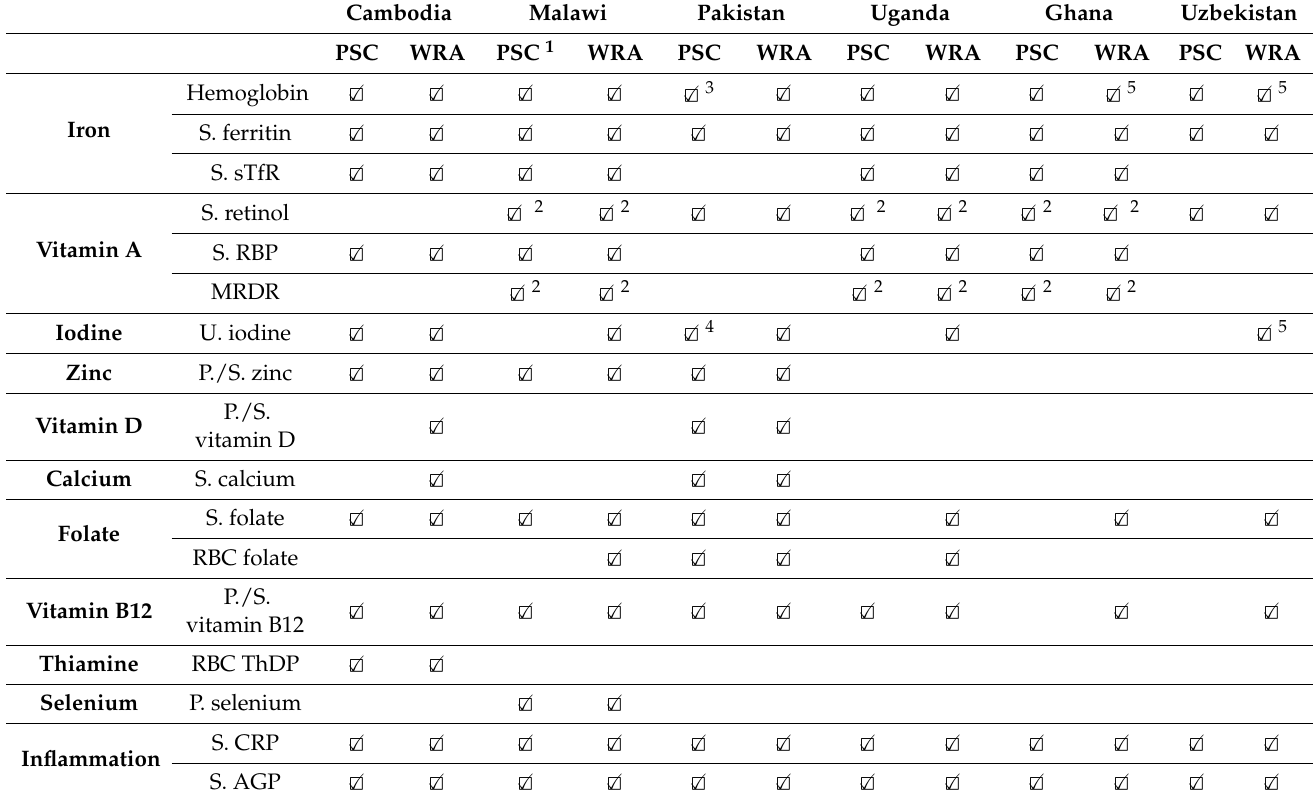
Table 2. Micronutrient biomarkers assessed in selected population groups in the six surveys for which key informant interviews were